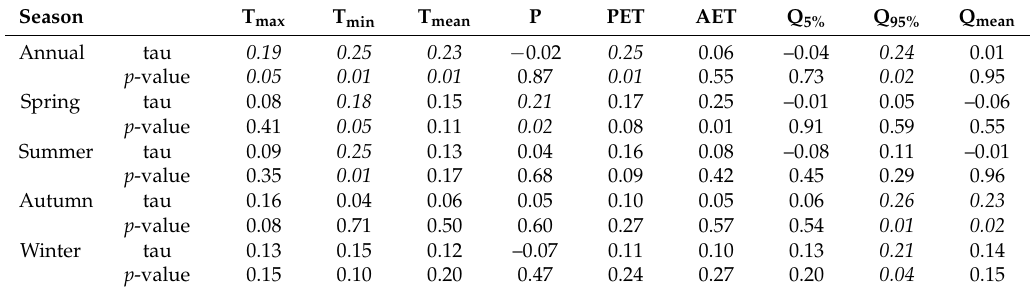
Table 2. Time-trend analysis of hydro-meteorological variables in the Deadman River watershed from 1962 to 2012 (spring: March–May; summer: June–August; autumn: September–November; winter: December–February; T max is maximum daily annual temperature ( ◦ C); T min is minimum daily annual temperature ( ◦ C); T mean is average daily annual temperature ( ◦ C); P is annual precipitation (mm); PET is potential evapotranspiration (mm); AET is actual evapotranspiration (mm); Q mean is annual mean flow (mm); Q 95% is the low flow parameter; Q 5% is the high flow parameter; tau is the z-statistic from the Mann–Kendall test indicating the direction of change of the variable; p -value is the level of significance from the Mann–Kendall test; and bolded italics indicate significant trends at a significance level of 0.05).